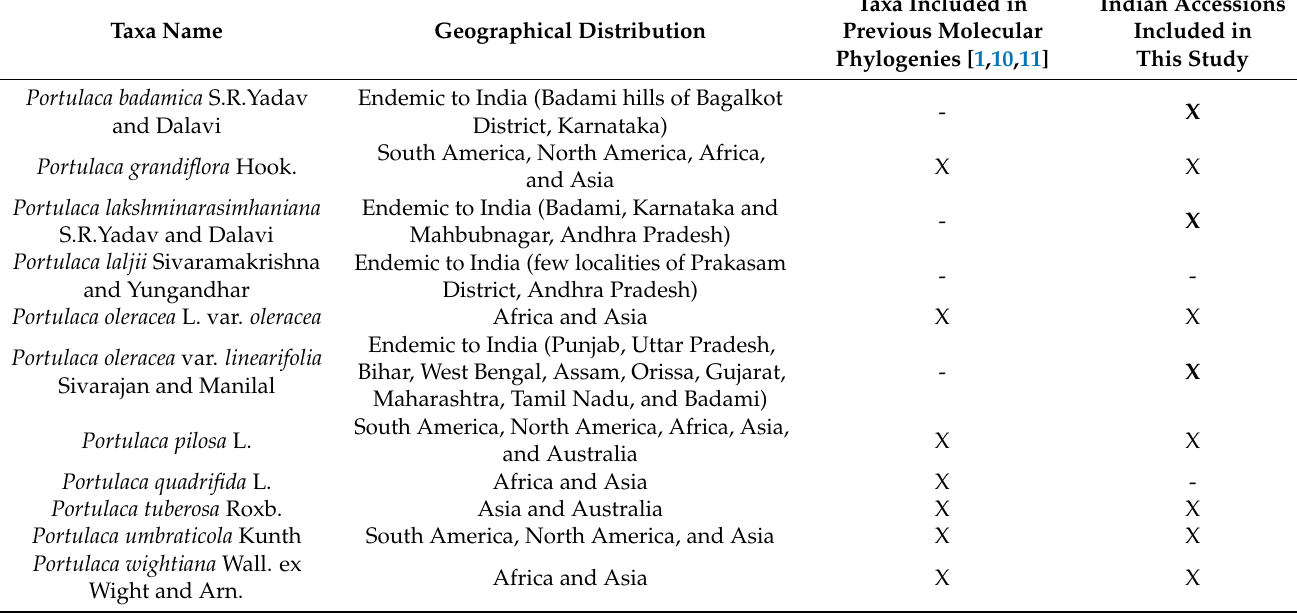
Table 1. List of Portulaca species that occur in India, their distribution, and representation in molecular studies. Taxa that occur in India and have never been included in a molecular study are marked with a cross in